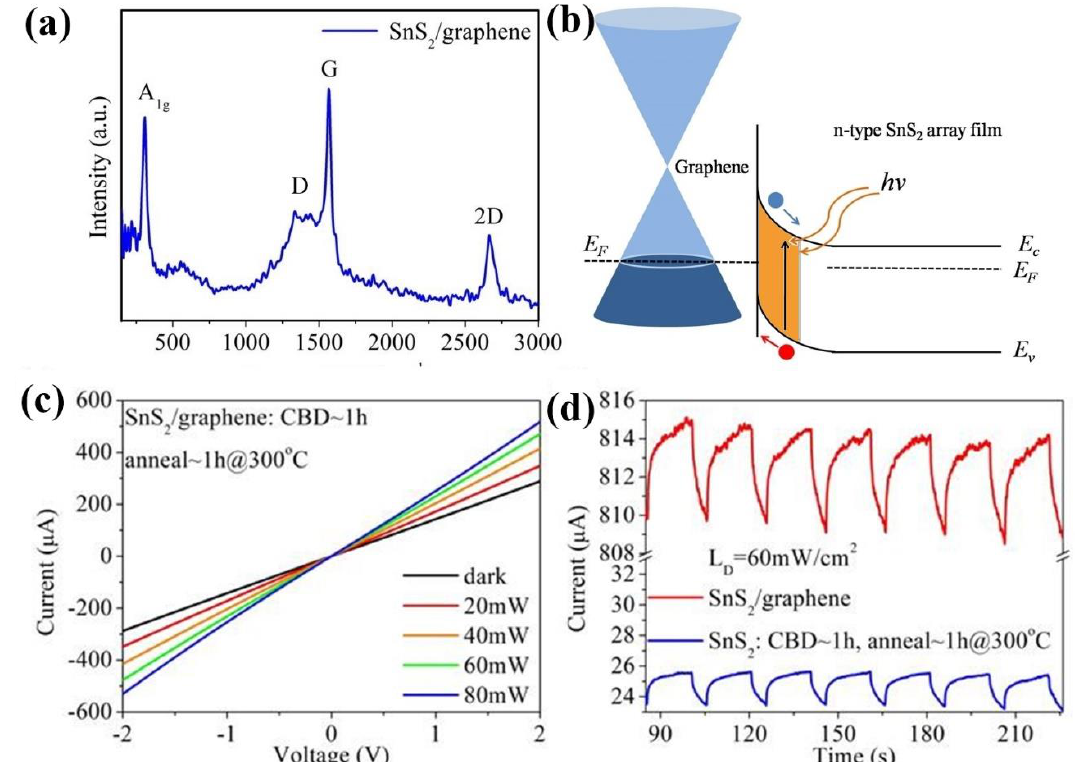
Figure 5. ( a ) Raman spectrum of SnS 2 /graphene composite films, ( b ) Schottky junction formed between graphene and SnS 2 array film, ( c ) I-V curves of SnS 2 /graphene photodetector under different optical power density illumination conditions, ( d ) I-t curves of photodetectors with and without graphene under the optical power density of 60 mW/cm 2 .